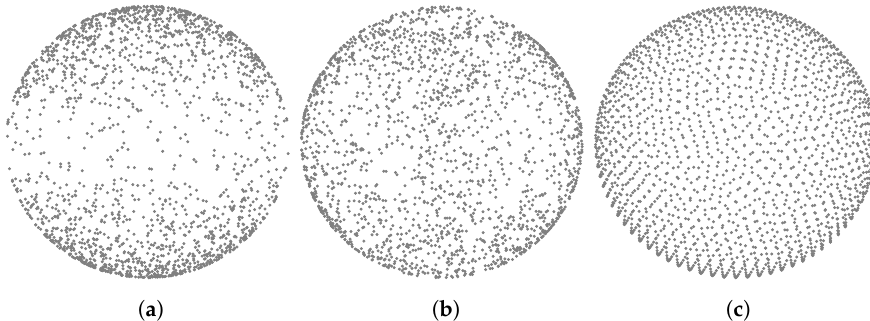
Figure 7. Comparison of three different points distributions on the surface of a sphere: ( a ) Cosine- weighted, ( b ) Uniform, ( c ) Fibonacci.